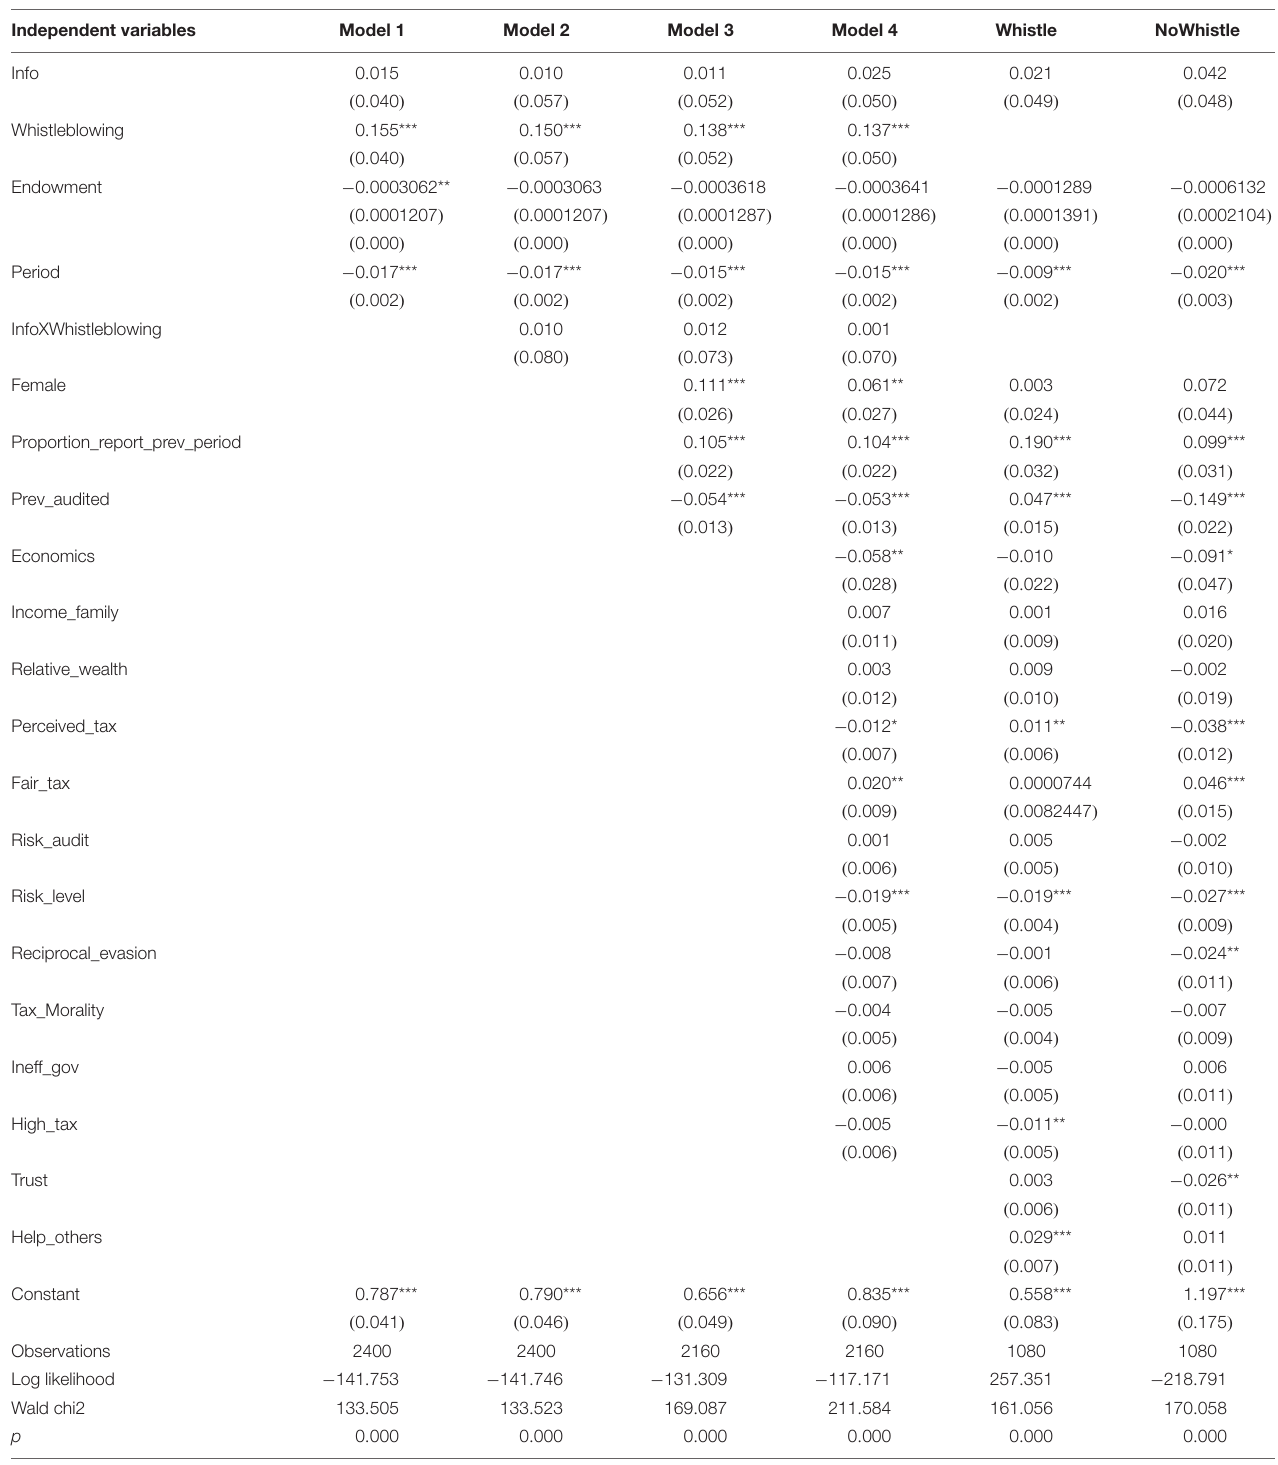
TABLE 2 | The determinants of the proportion of income reported in the tax evasion game: Multilevel models, with standard errors clustered at both at the group and at the subject level. Independent